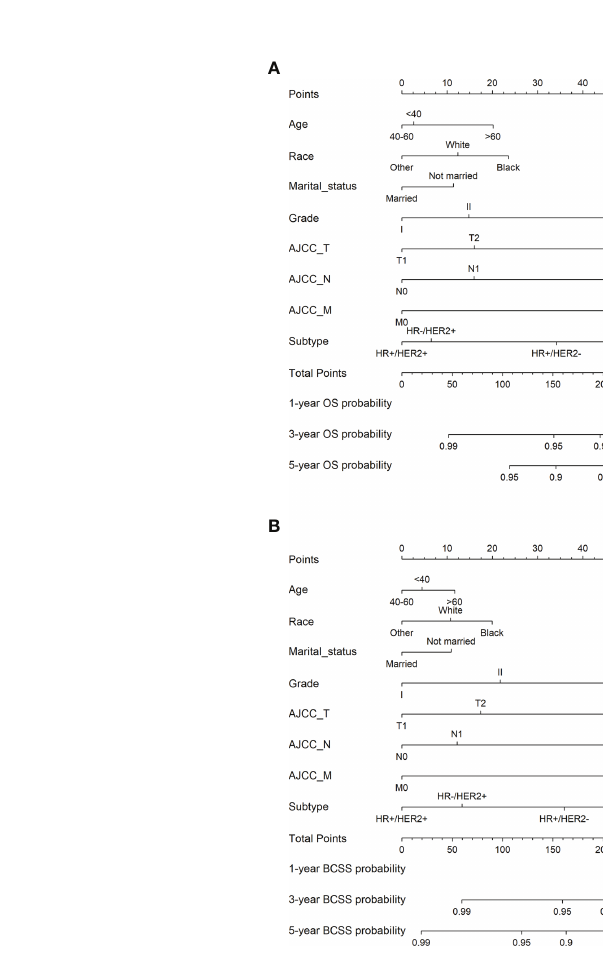
FIGURE 8 1-, 3-, 5-year probability prediction of overall survival (A) and breast cancer speci fi c survival (B) in radiotherapy patients. OS, overall survival; BCSS, breast cancer-speci fi c